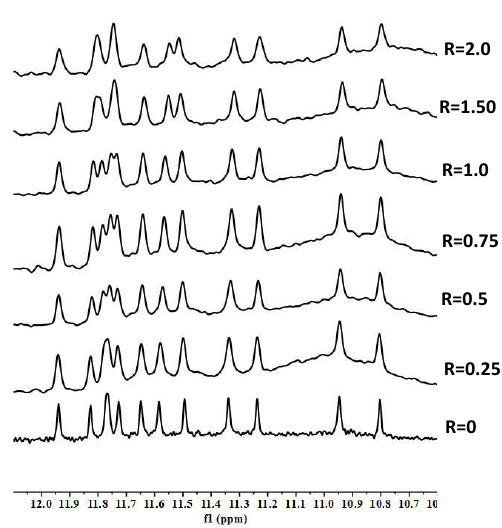
Figure 11. Imino proton region of 1D NMR titration spectra of TP3-T6 with pyridostatin at 25 ◦ C at Figure 11 . Imino proton region of 1D NMR titration spectra of TP3- T6 with pyridostatin at 25 °C at different R = (drug)/(DNA) ratios. different R = (drug)/(DNA) ratios. Table 1. Table summarizing the main interactions observed in the TP3-T6/Ligands complexes as obtained by molecular modeling. The table shows the nucleotides involved in the interactions together with the type of